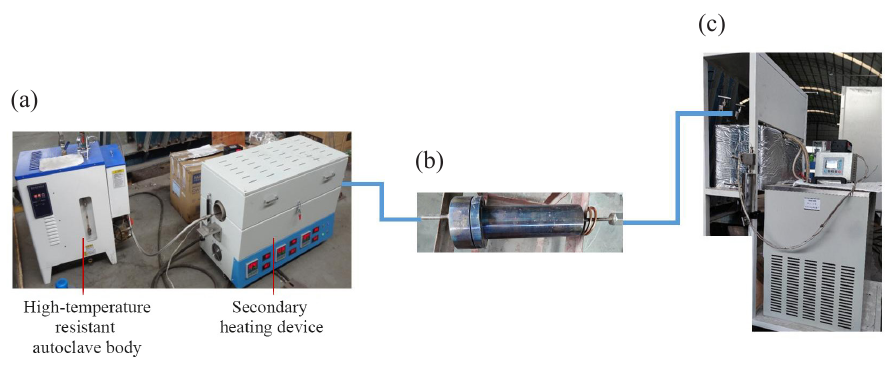
Fig. 1. The water vapor system of oil shale pyrolysis: (a) water vapor generator; (b) high-temperature resistant reactor; (c) oil and gas condensing